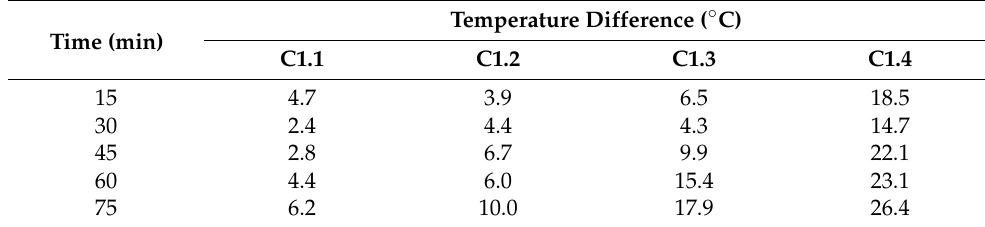
Table 7. The temperature difference between the surface of SUS304 and coating surface of C. Coating Surface of